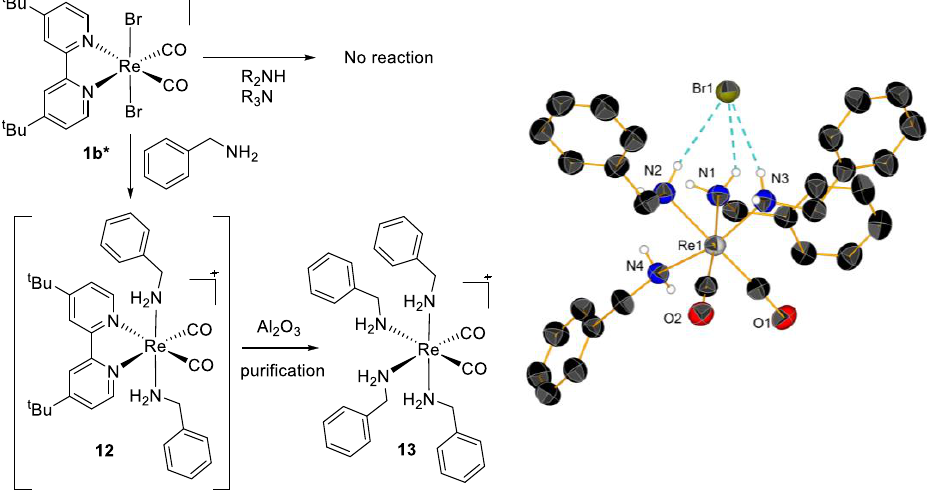
Figure 4. ( Left ): schemes of the reactions of 1b* with model primary, secondary and tertiary amines. ( Right ): ORTEP representations of crystal structures of rhenium complex 13 obtained from the decomposition of 12 . Thermal ellipsoids are at 30% probability. Hydrogen atoms are omitted for clarity.